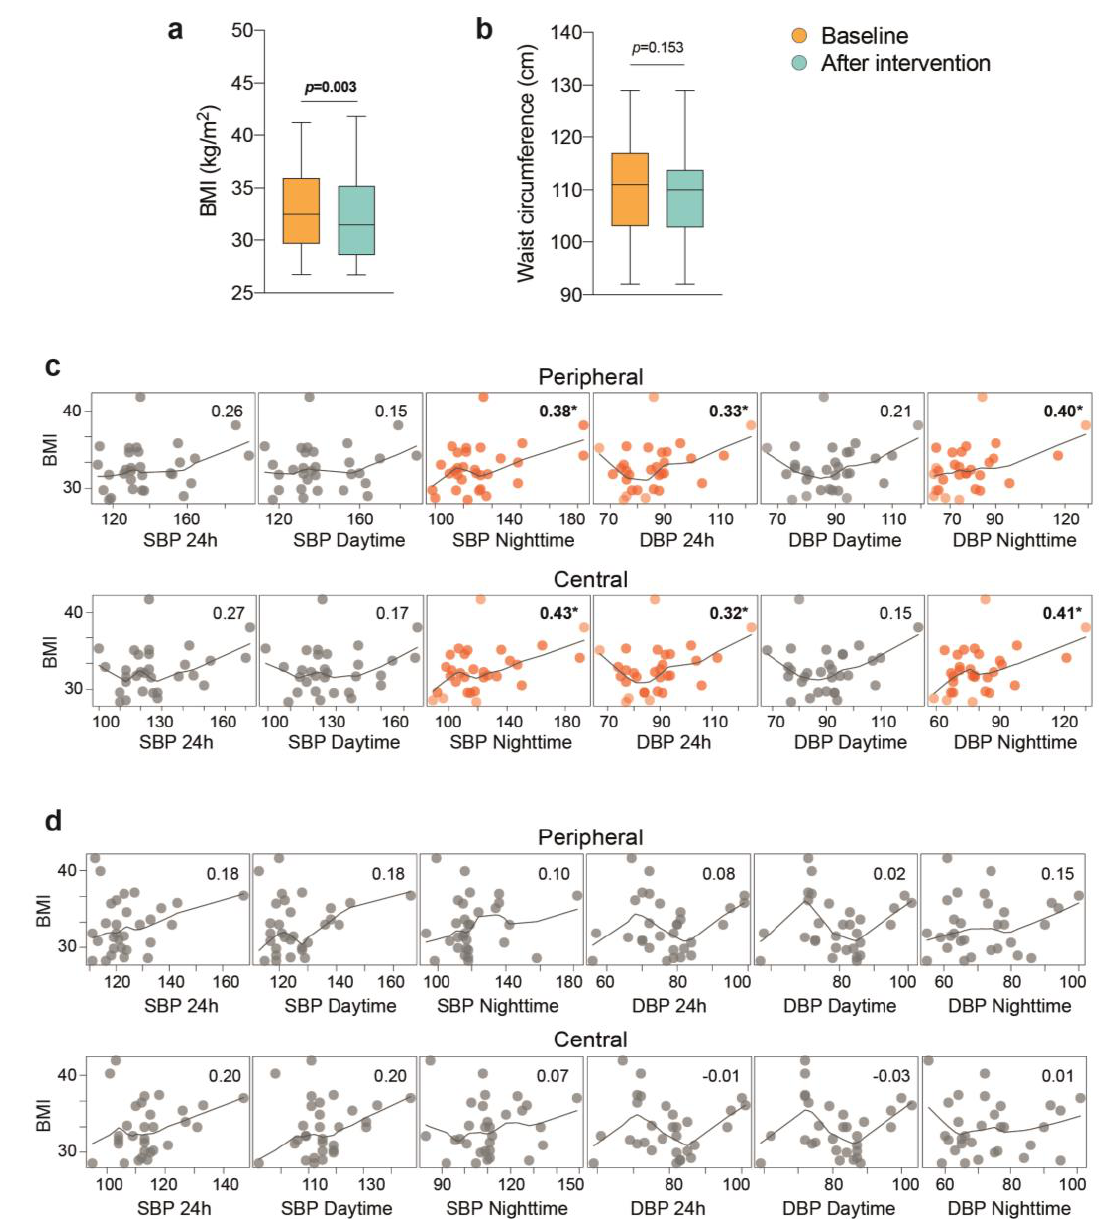
Figure 3. The intervention modified the relationship between weight loss and blood pressure in patients with resistant hypertension. ( a ) Body mass index (BMI). ( b ) Waist circumference. Significant correlation plots with the fitted line at baseline ( c ) of systolic (SBP) and ( d ) diastolic (DBP) blood pressure with BMI were not maintained after the intervention. Pearson’s correlation coefficient is represented in the upper and right part of each plot, and significance is with an asterisk and numbers in bold.